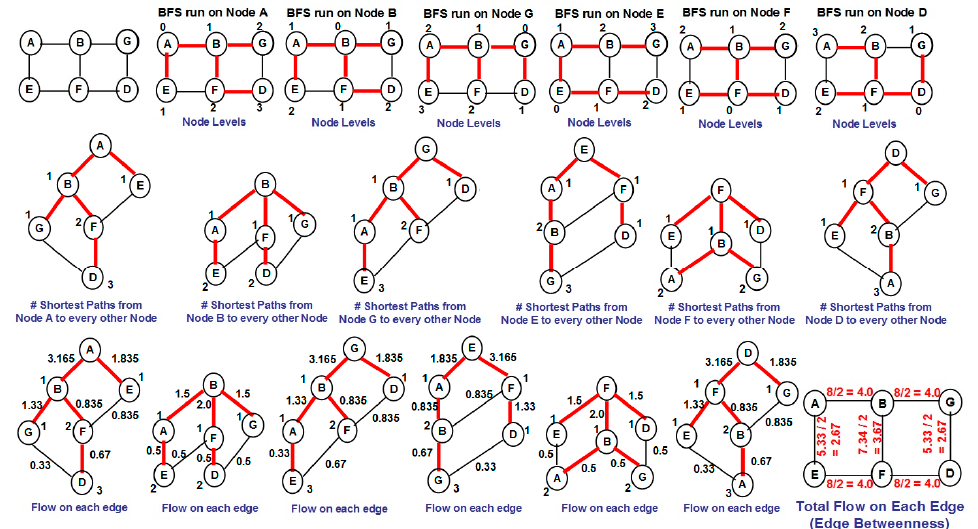
Figure 5. Example to illustrate the calculation of edge betweenness.